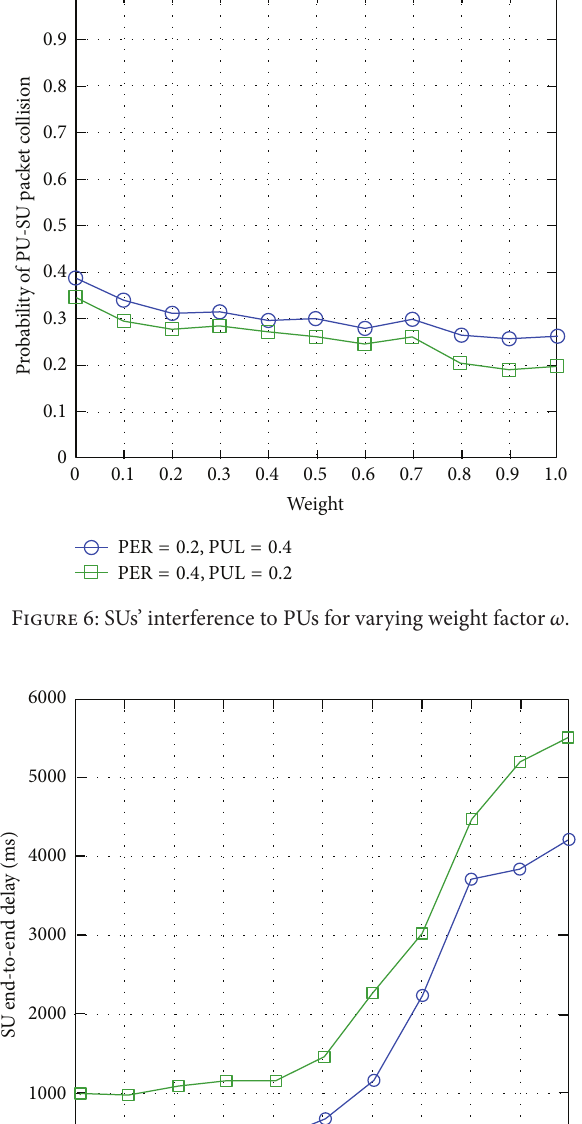
PER because PUL has a direct effect on the PU-SU packet collisions; hence, higher PULs indicate higher probability of PU-SU collisions. 4.3.2. SU End-to-End Delay. Figure 7 shows that the SU